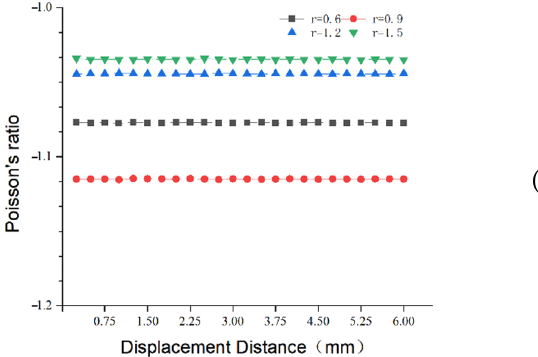
Figure 4. Physical field at each node radius, displacement field in x-direction and displacement field in y-direction: ( a ) r = 0.6 mm;( b ) r = 0.9 mm; ( c ) r = 1.2 mm; ( d ) r = 1.5 mm.